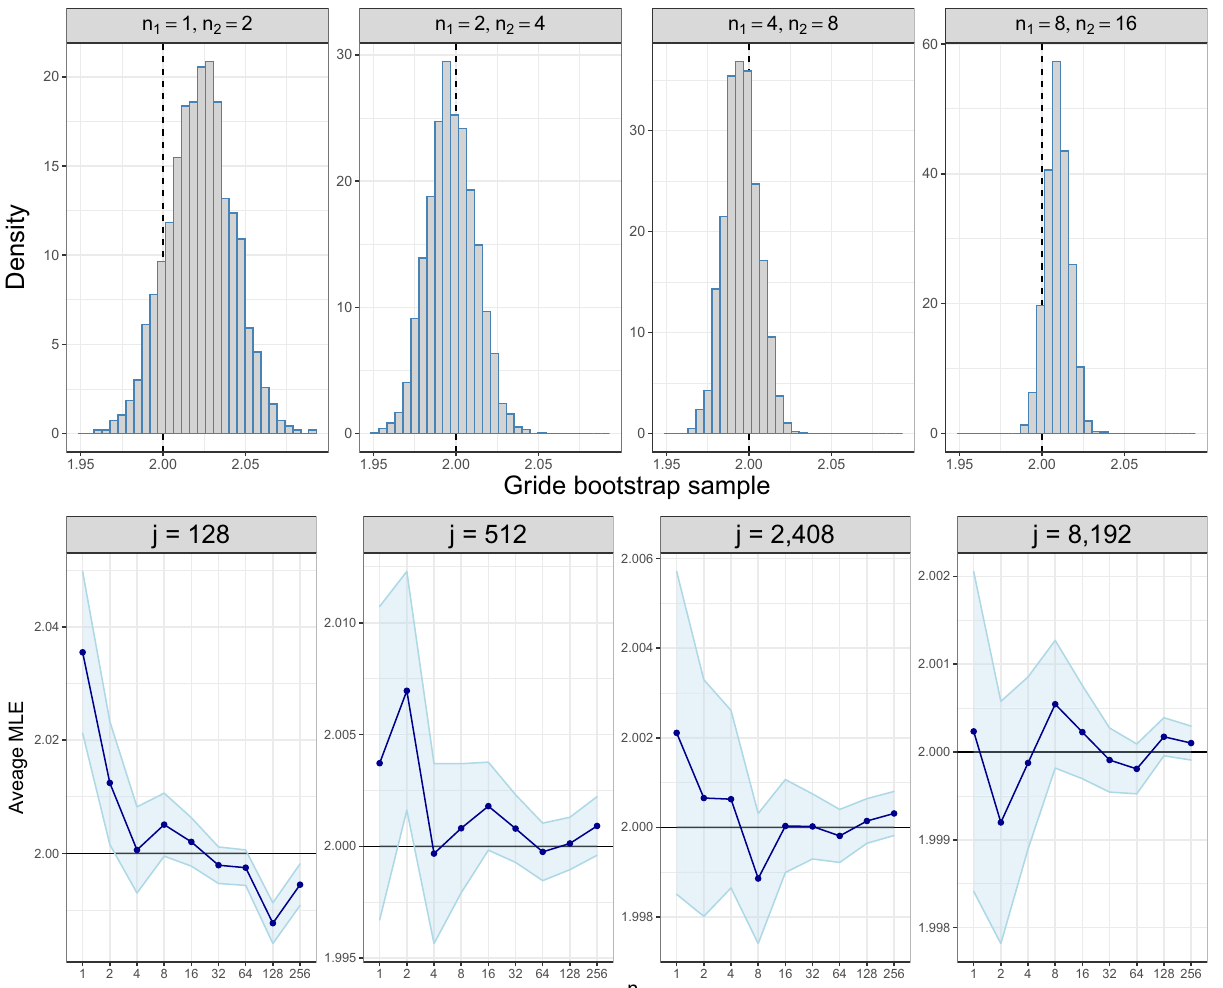
Figure 3. Top row: histograms of the Gride parametric bootstrap samples estimated within the frequentist framework for different NN orders. Note that the first panel corresponds to the TWO-NN model. Bottom row: average Gride MLE obtained over different NN orders. The various panels showcase the different neighborhood sizes that are considered for computing the estimates. The error bands display the 95% confidence intervals on the average